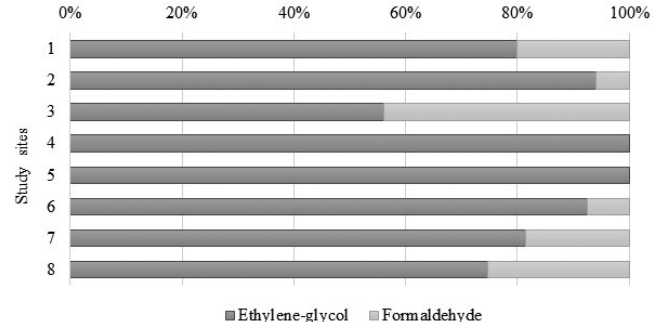
Figure 2. Ethylene glycol to formaldehyde ratio of sampled specimens from all study sites, where both fixating solutions were